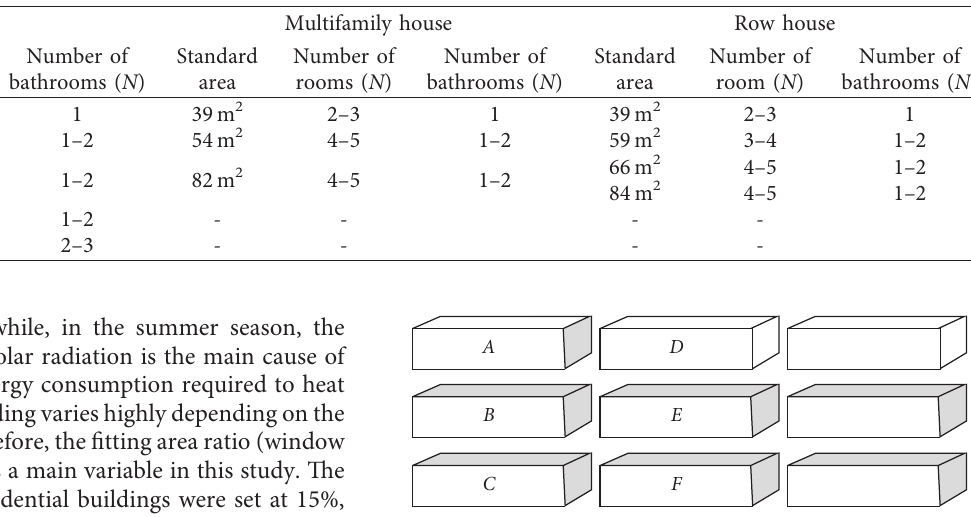
Figure 4: Setting of insulation boundary